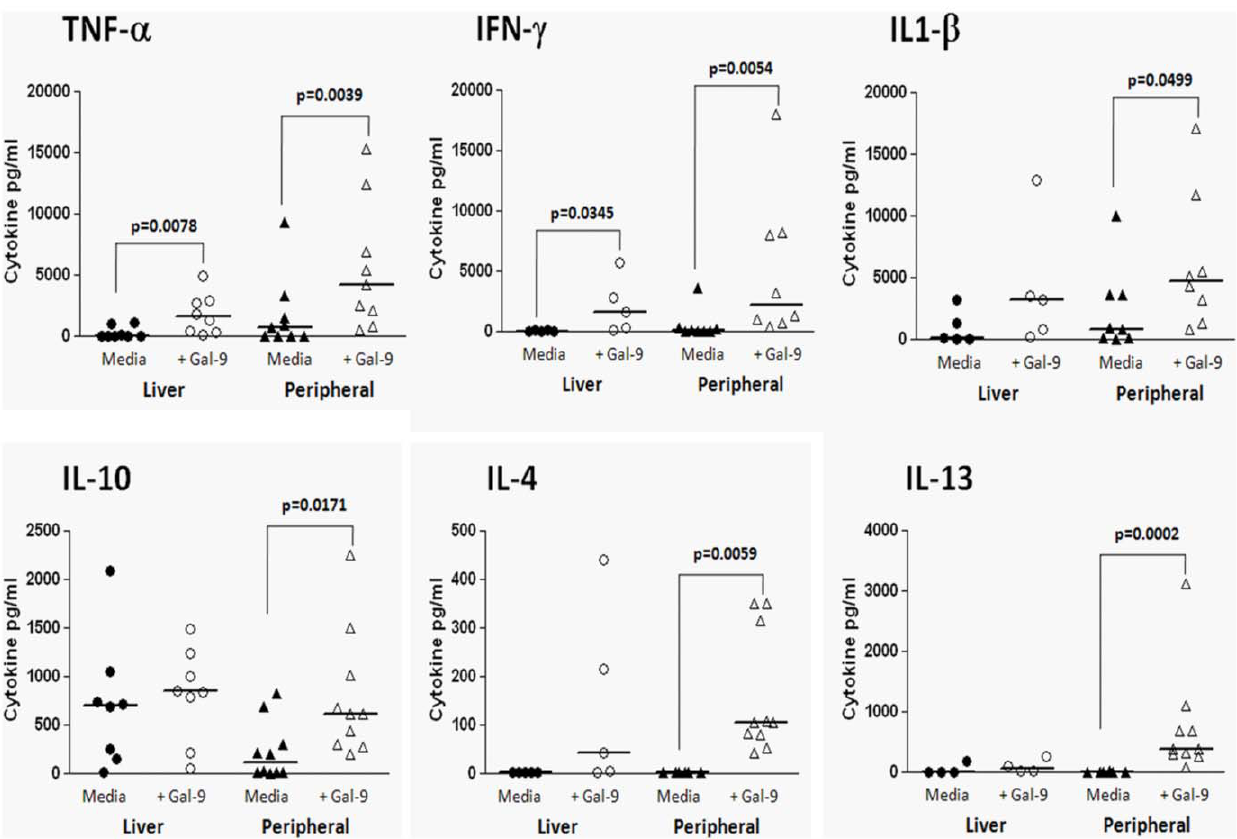
Figure 4. Galectin-9 induces cytokine secretion from liver-derived and peripheral mononuclear cells. Hepatic (n=8) or peripheral (n=8) mononuclear cells (2 6 10 6 /ml) were cultured in 96-well plates (200 ul/well) for 48 hours in media alone (RPMI + 10% human serum) 6 galectin-9 (5 ug/ ml). After the culture period supernatants were collected and cytokine levels were measured using cytokine multiplex (Luminex TM ) technology as described in materials and methods. P-values were calculated using the Wilcoxan matched-pairs signed rank